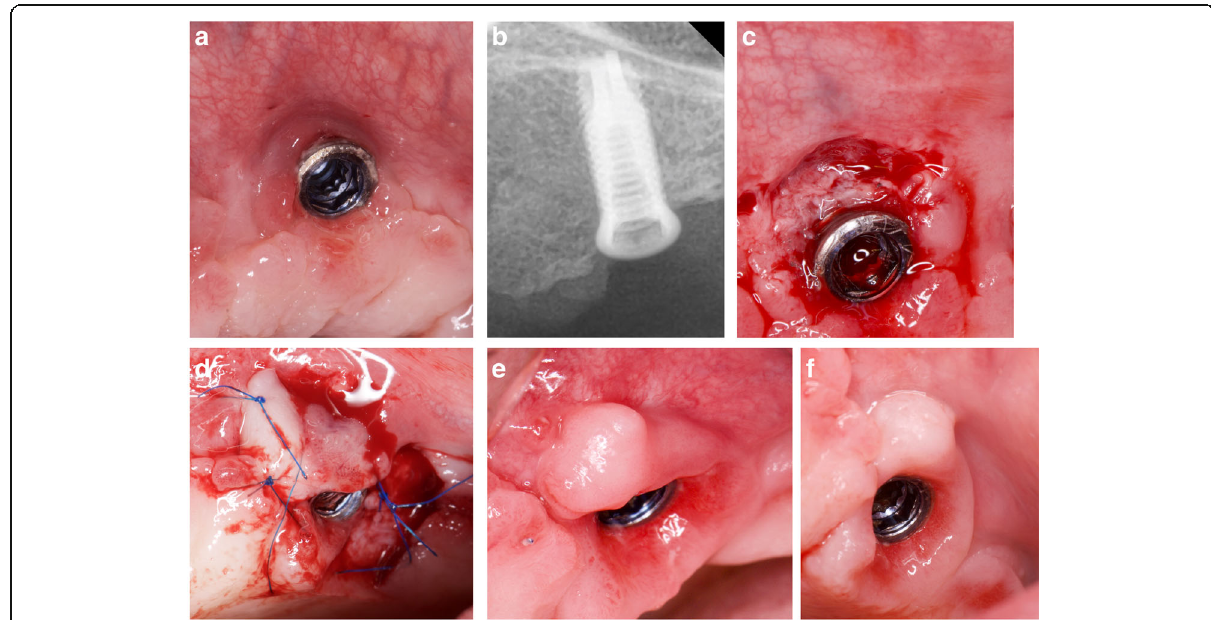
Fig. 3 Laterally rotated flap from the distal crestal area. Maxillary dental implant in a totally edentulous arch. Dental implant buccally positioned and with 1-mm buccal surface exposure. a Peri-implant mucositis with lack of keratinized tissue around implant. b X-ray showing no peri-